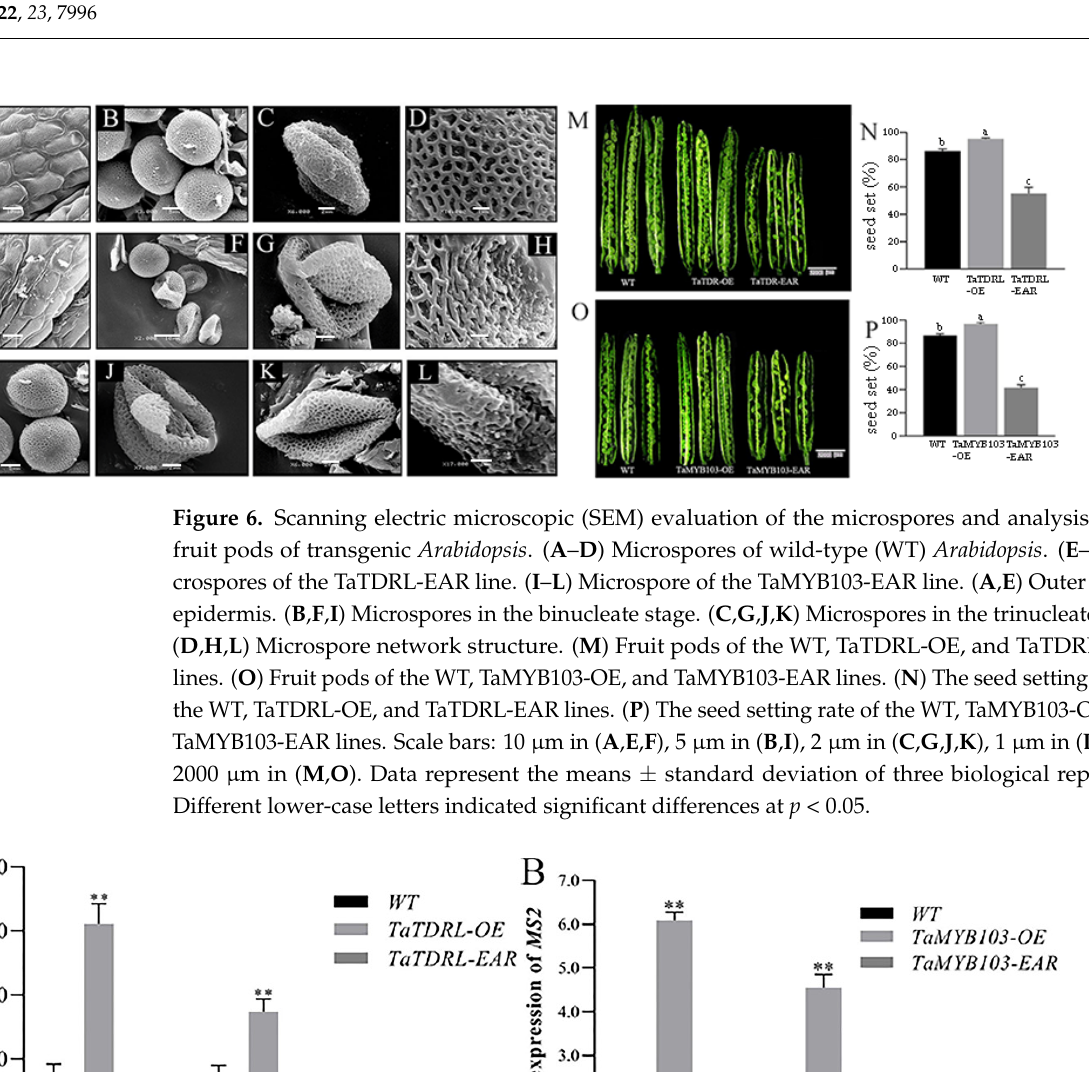
Figure 6. Scanning electric microscopic (SEM) evaluation of the microspores and analysis of the fruit pods of transgenic Arabidopsis . ( A – D ) Microspores of wild-type (WT) Arabidopsis . ( E – H ) Microspores of the TaTDRL-EAR line. ( I – L ) Microspore of the TaMYB103-EAR line. ( A , E ) Outer anther epider- mis. ( B , F , I ) Microspores in the binucleate stage. ( C , G , J , K ) Microspores in the trinucleate stage. ( D , H , L ) Microspore network structure. ( M ) Fruit pods of the WT, TaTDRL-OE, and TaTDRL-EAR lines. ( O ) Fruit pods of the WT, TaMYB103-OE, and TaMYB103-EAR lines. ( N ) The seed setting rate of the WT, TaTDRL-OE, and TaTDRL-EAR lines. ( P ) The seed setting rate of the WT, TaMYB103- OE, and TaMYB103-EAR lines. Scale bars: 10µm in ( A , E , F ), 5 µm in ( B , I ), 2µm in ( C , G , J , K ), 1 µm in ( D , H , L ), 2000 µm in ( M , O ). Data represent the means ± standard deviation of three biological repli- cates. Different lower-case letters indicated significant differences at p < 0.05.